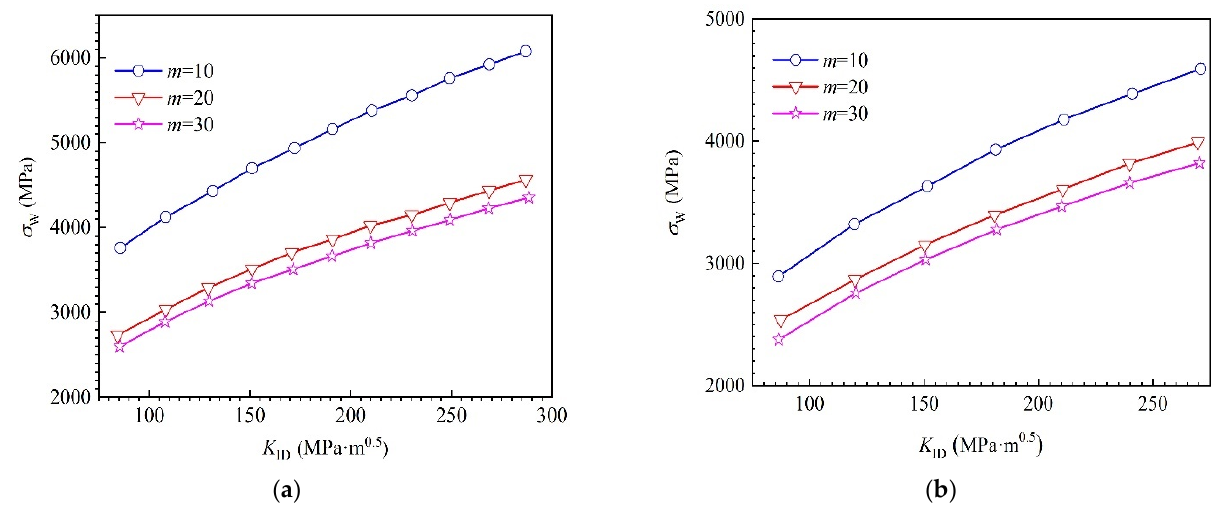
σ curve of CT sample ( a ) 1T-CT sample and ( b ) 0.5T-CT sample. K - Figure 13. Figure 13. K ID - σ W curve of CT sample ( a ) 1T-CT sample and ( b ) 0.5T-CT sample. ID W